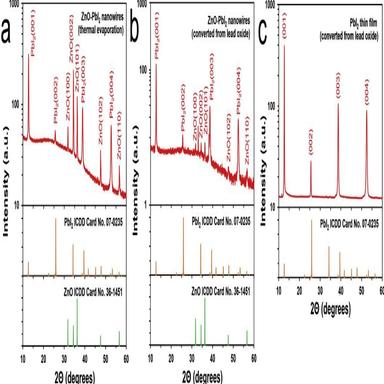
X-ray diffraction patterns of (a) ZnOePbI2 NW arrays on Si/SiO2 substrate made using the thermal evaporation approach; (b) ZnOePbI2 NW arrays on Si/SiO2 substrate made by converting the magnetron-sputtered lead oxide coating; (c) PbI2 thin film made by converting a lead oxide film.